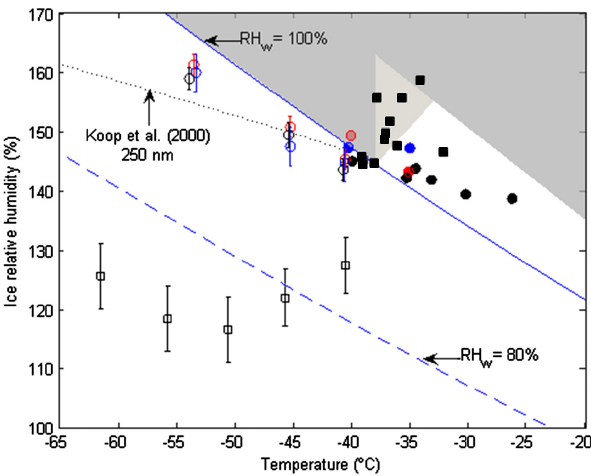
Fig. 4. Conditions for ice nucleation on 1% of SOA-coated ATD particles as a function of temperature for sizes: 160nm (red), 250nm (blue), 340nm (black). Open symbols represent data col- lected with the laboratory unit and filled symbols represent data collected with the aircraft unit. Conditions for ice nucleation on 1% uncoated 200nm ATD particles (black squares) are included for reference. The dark gray shading indicates the region where droplets are known to be counted by the OPC in the CFDC systems. The light gray shading indicates the transition where the state of the particle counted by the OPC is ambiguous. Water saturation, RH w = 80% and the conditions for which 250nm (NH 4 ) 2 SO 4 par- ticles nucleate ice according to Koop et al. (2000) are indicated in the figure for